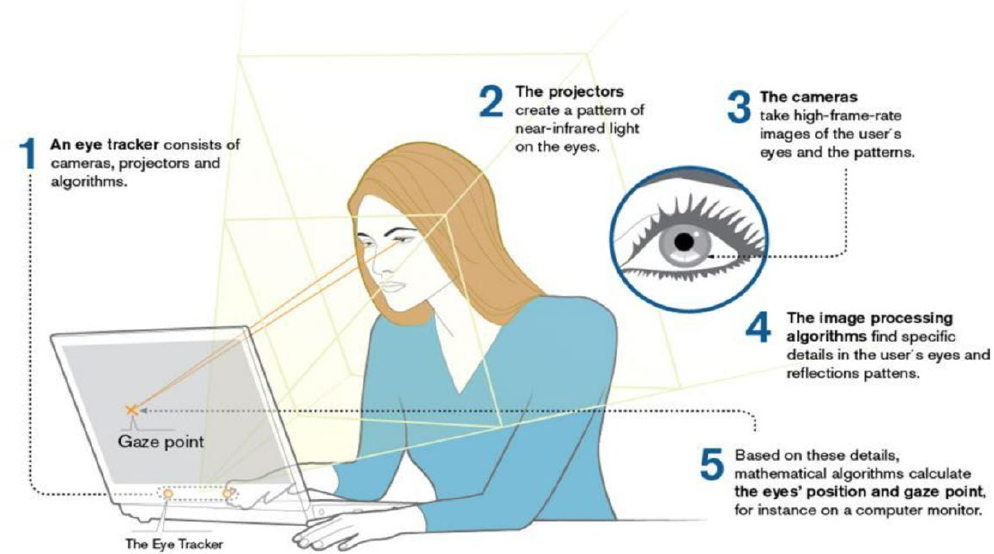
Close infrared light is coordinated towards the focal point of the eyes; causing noticeable disparity in the cornea which is the external optical component of the eye. While the noticeable range is probably going to produce uncontrolled specular reflection, infrared light isn't detectable by the human eye and along these lines takes into consideration an exact separation between the student and the iris while